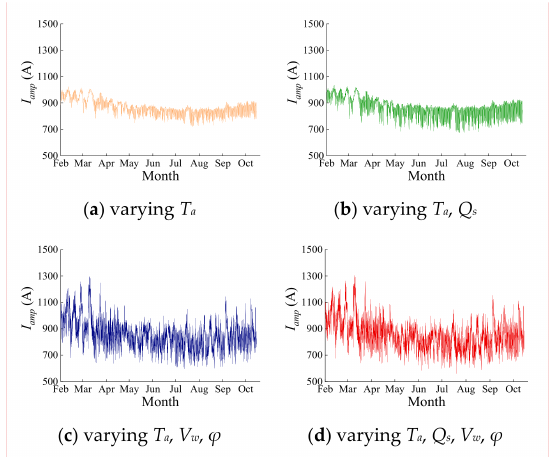
Figure 1. Ampacity due to variation in weather parameter